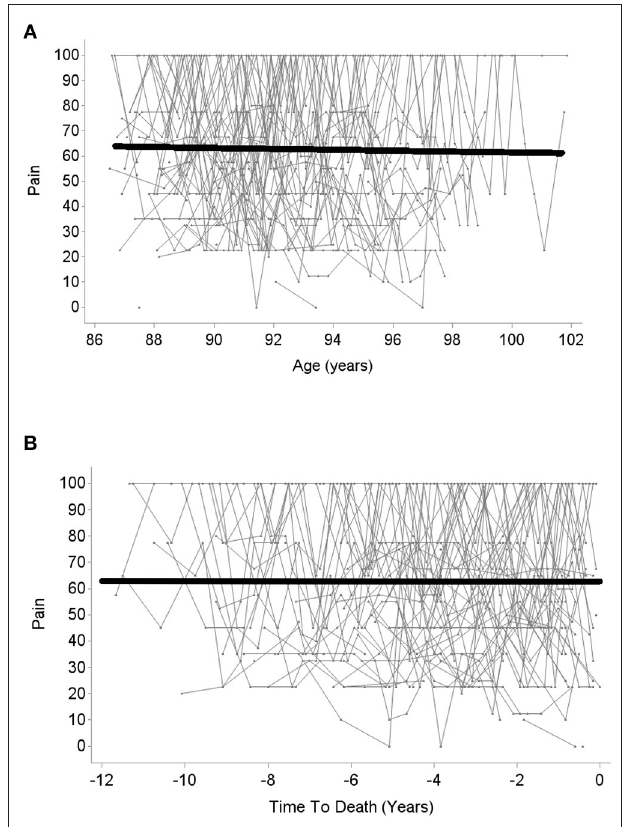
FIGURE 1 | Change in pain over age (A) and over time to death (B) . Higher scores indicate lower pain.